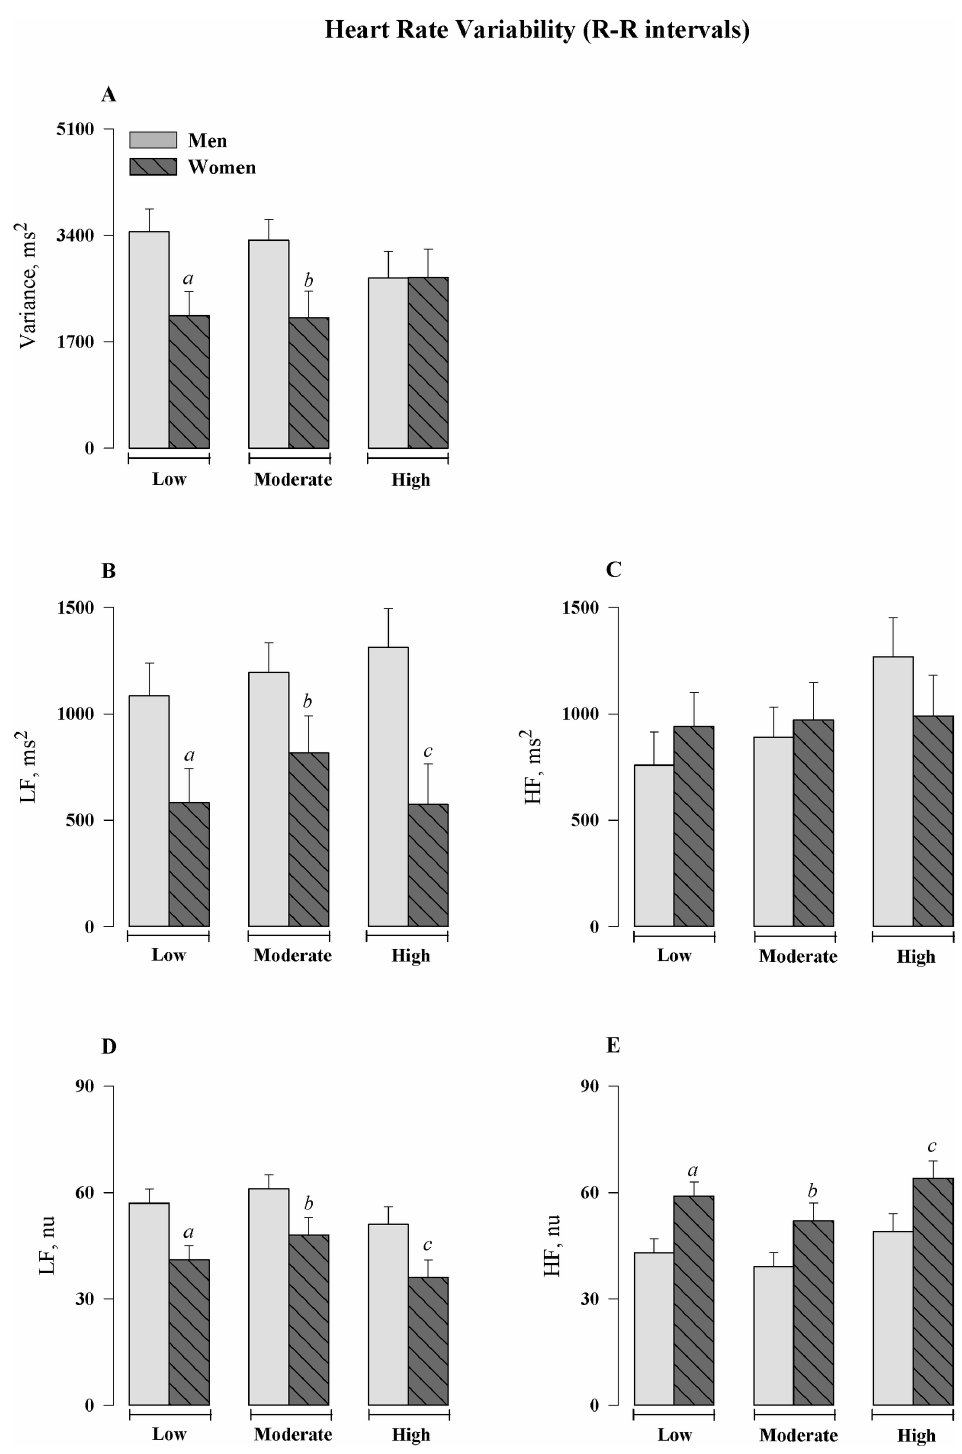
Figure 1. Heart Rate Variability (R-R intervals). (A) Total variance of heart rate obtained by means of series of R–R interval (ms 2 ). (B and C) Spectral power density of heart rate in low (LF) and high frequencies (HF) in absolute values. (D and E) Spectral power density of heart rate in the LF and HF bands in normalized units (nu), respectively. Values are means ± S.E.M. a P<0.05 vs . Men Low Aerobic Capacity Group; b P<0.05 vs . Men Moderate Aerobic Capacity Group; c P<0.05 vs . Men High Aerobic Capacity Group. doi: 10.1371/journal.pone.0077092.g001 PLOS ONE |